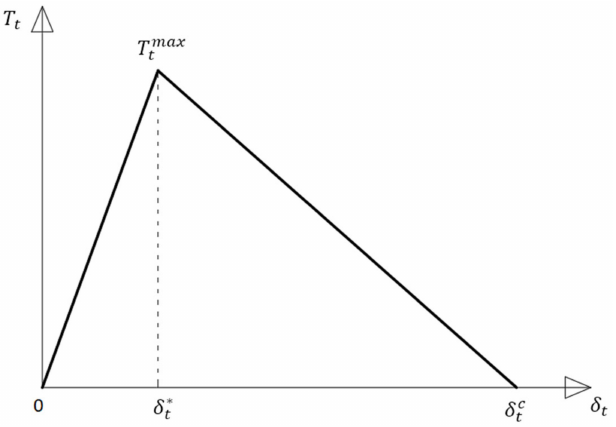
Figure 6. The bilinear, Mode II